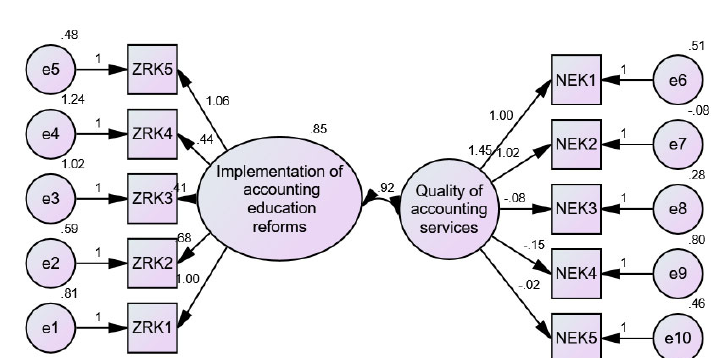
Fig. 3. The results of the SEM implementation of accounting education-Quality of accounting services